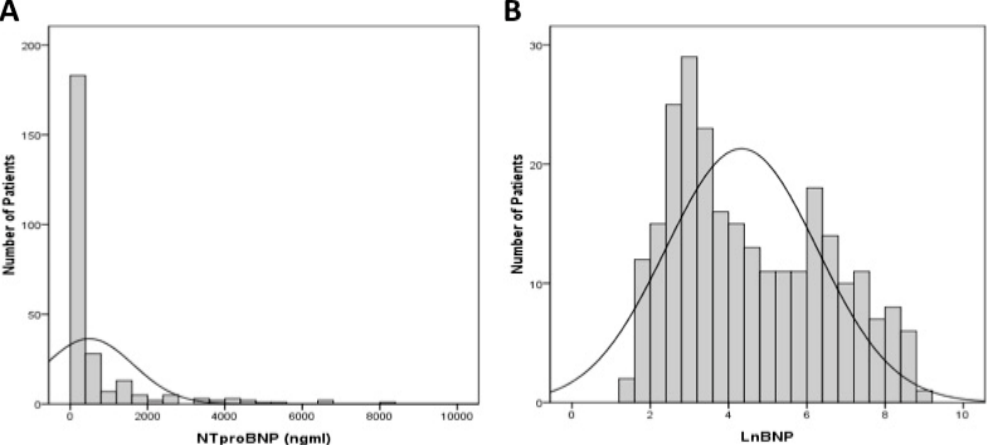
Figure 2. Distribution of serum NT-proBNP in the entire cohort. ( A ) NT-proBNP levels. ( B ) Natural log-transformed NT-proBNP levels. NT-proBNP, N-terminal pro-Brain type natriuretic peptide. PD patients with high NT-proBNP levels (mean 1141 ± 1530 ng/mL) had a significantly longer duration of PD ( p < 0.01) prior to enrolment, a higher prevalence of heart failure ( p < 0.01), higher peritoneal Kt/V ( p < 0.01) but lower renal Kt/V ( p < 0.01), and lower Hb ( p < 0.01) levels than those with low NT-proBNP levels (mean 23 ± 14 ng/mL) (Table 1). Those with high NT-proBNP had significantly higher CTR ( p < 0.01), extracellular to intracellular water ratio (E/I) ( p < 0.01), and greater over-hydration (OH) severity ( p < 0.01), than those with low levels (Table 1). There was no significant difference with regard to PET status between patients with low and high NT-proBNP levels. LnBNP levels correlated significantly with gender ( p < 0.01), renal Kt/V ( p < 0.01), Hb ( p < 0.01) levels, CTRs ( p < 0.01), and relative OH extent ( p < 0.01) (Table 2). A multivariate linear regression analysis revealed that lower renal Kt/V ( β = − 1.55, p < 0.01), higher degree of overhydration ( β = 0.08, p < 0.01), CTR ( β = 0.04, p = 0.02), and the presence of heart failure ( β = 0.97, p < 0.01) were independently associated with higher NT-proBNP levels at baseline. Table 1. Comparison of clinical characteristics between PD patients with low and high BNP levels Total ( n = 258)